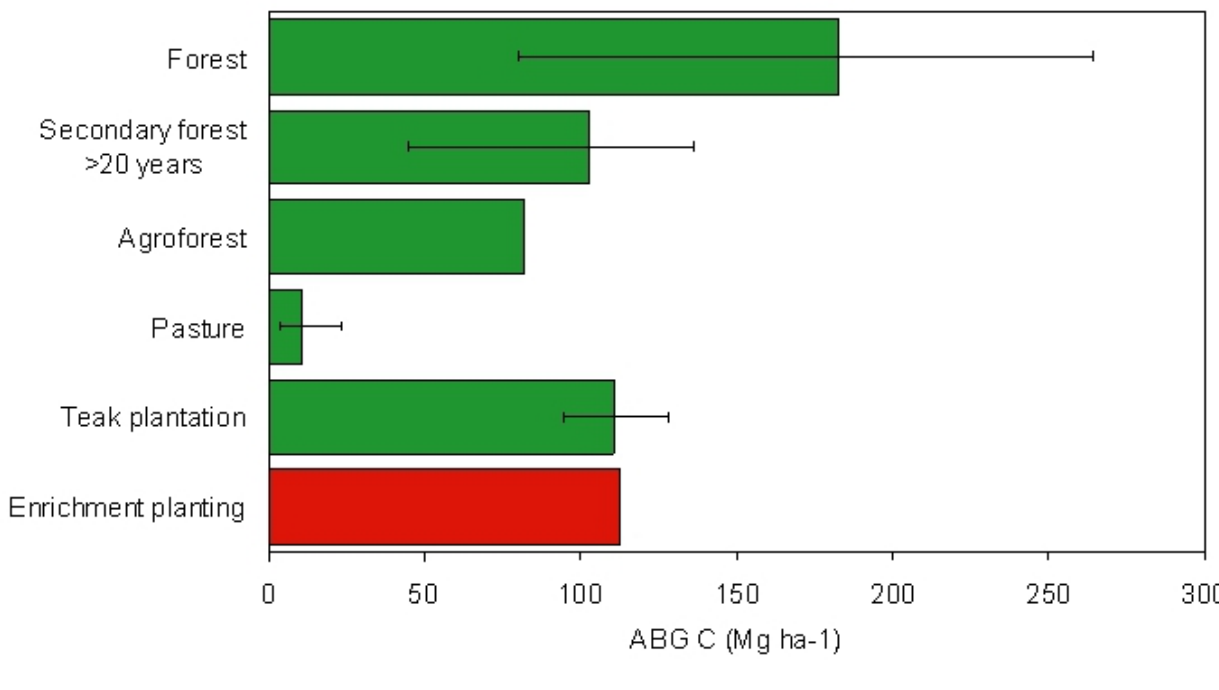
Fig. 3. Aboveground (ABG) carbon storage of various land-use types in the humid tropics. Carbon storage is based on average rotation periods for each land-use type, i.e., the time over which carbon is stored. An average value was computed when more than one source was available (range represented with error bars). Enrichment-planting value was estimated from averaged teak monoculture plantation and secondary forest (>40 years) values. Additional information, references and timescales available